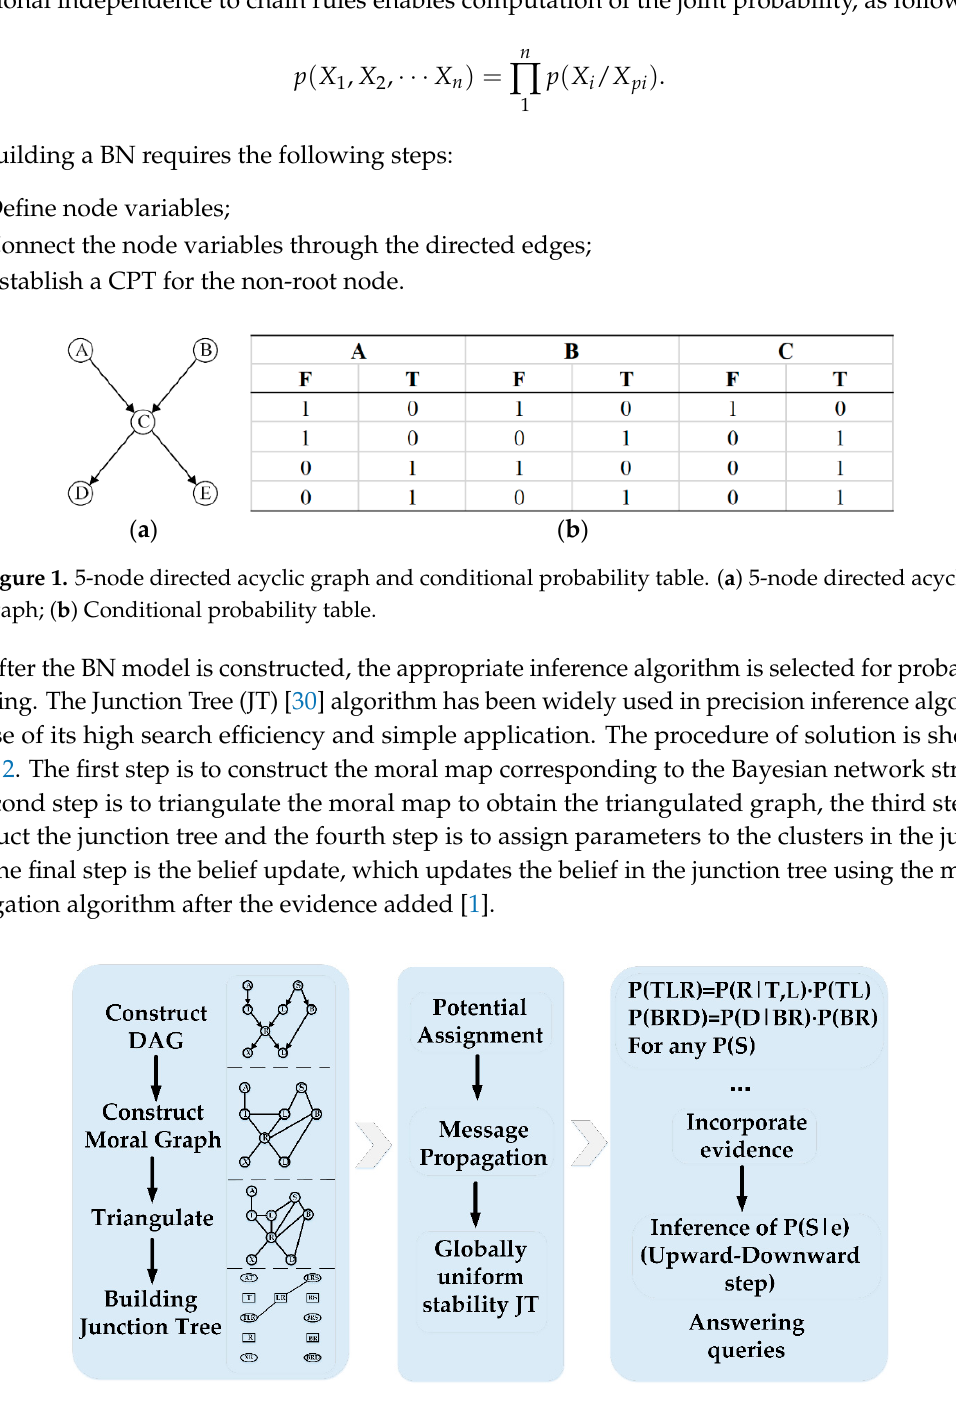
Figure 2. The procedure of Junction Tree (JT) algorithm and build thought of JT. DAG: directed acyclic graph.